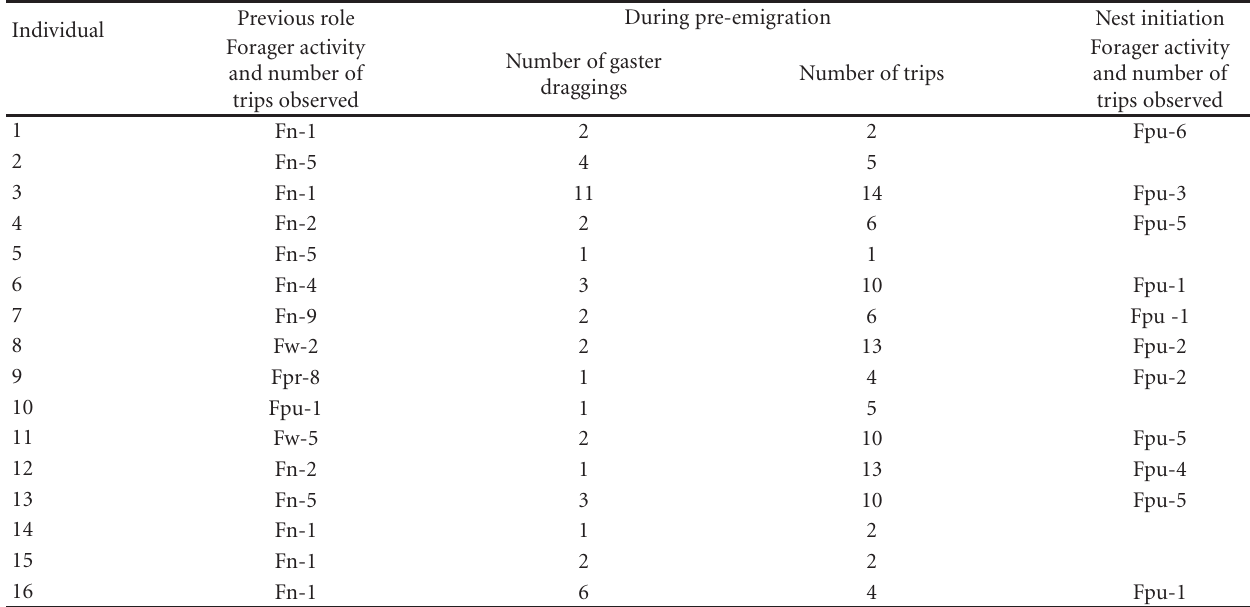
Table 2: Examples of di ff erent behavioral roles displayed by selected individual scouts of Pa. fraternus from colony C5 which were the most active foragers and scouts during pre-emigration and nest initiation. Previous role, forager activity: Fn = forager nectar; Fw = forager water, Fpr = forager prey; Fpu = forager pulp. During pre-emigration, individual number of gaster-dragging events on the substrate near natal nest entrance, and number of trips to the new nest site. Nest initiation, forager activity, and number of trips per individual. Previous role During pre-emigration Nest initiation Individual Forager activity Forager activity Number of gaster and number of Number of trips and number of draggings trips observed trips